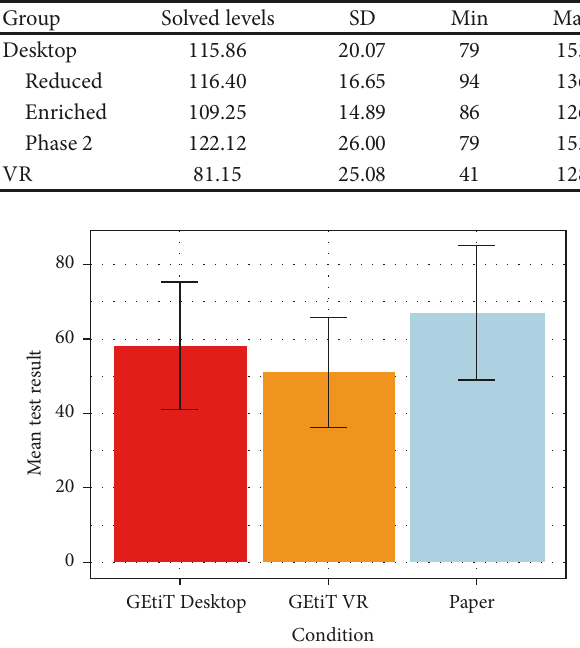
Figure 11: Graphical comparison of the test results between the desktop-Group , the vr-Group , and the paper-Group . Error bars indicate standard deviations.